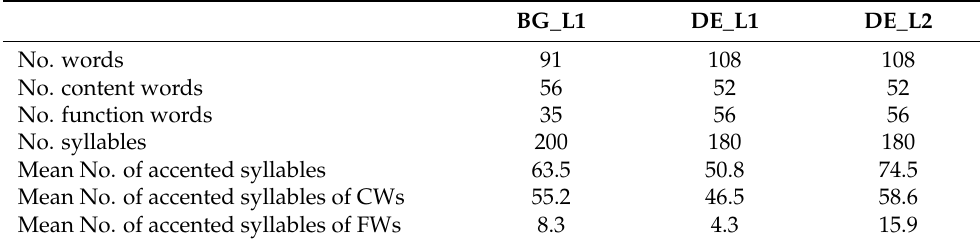
Table 1. Words and syllables in the three data sets: exploratory